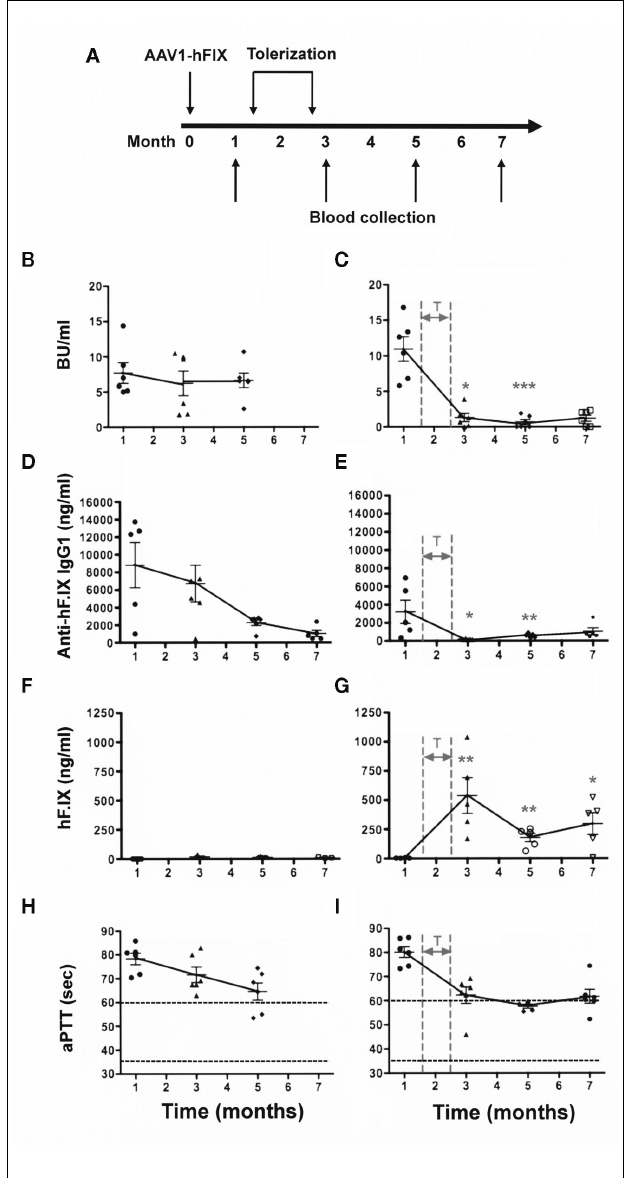
FIGURE 1 | Elimination of a pre-existing/ongoing anti-hF.IX immune response. C3H/HeJ F9 − / − mice ( n = 12) were injected IM with AAV1-CMV-hF.IX (1 × 10 11 vg/mouse) to generate an immune response. After demonstrating the existence of an immune response, half of the animals were given rapamycin/IL-10/specific peptide for 4weeks [right panels: (C,E,G,I) ]. Controls [left panels: (B,D,F,H) ] only received gene transfer. (A) Experimental timeline. (B,C) Inhibitory antibody titers (in BU/ml). (D,E) Anti-hF.IX IgG1 antibody (ng/ml). (H,G) hF.IX plasma levels (ng/ml). (H,I) Coagulation times (aPTT in s). Data are shown as a function of time after vector administration in control mice (treated with vector only, left panels) or mice that received the immune modulation/tolerance regimen (starting 1.5months after vector administration, indicated as “T” in right panels). Results are shown as averages at each time point ( ± SEM) and for individual animals. Statistically significant differences between the immune modulated and control groups ( n = 6 per group) at a specific time point are indicated as gray asterisk in the panels of the immune modulated group with * P < 0.05, ** P < 0.01, and *** P <